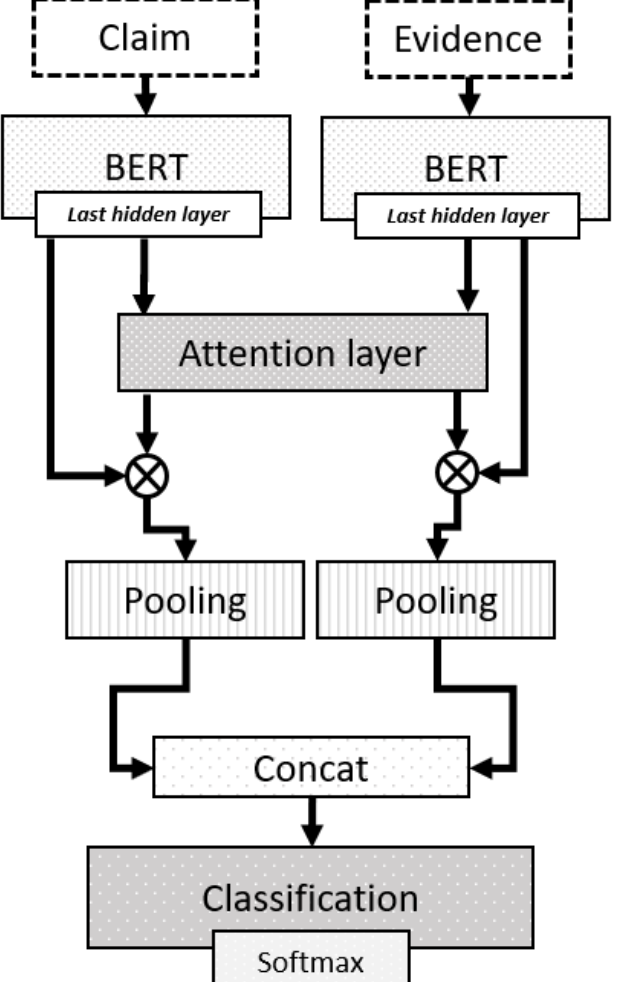
Figure 2. Architecture proposed to evaluate relevance and claim